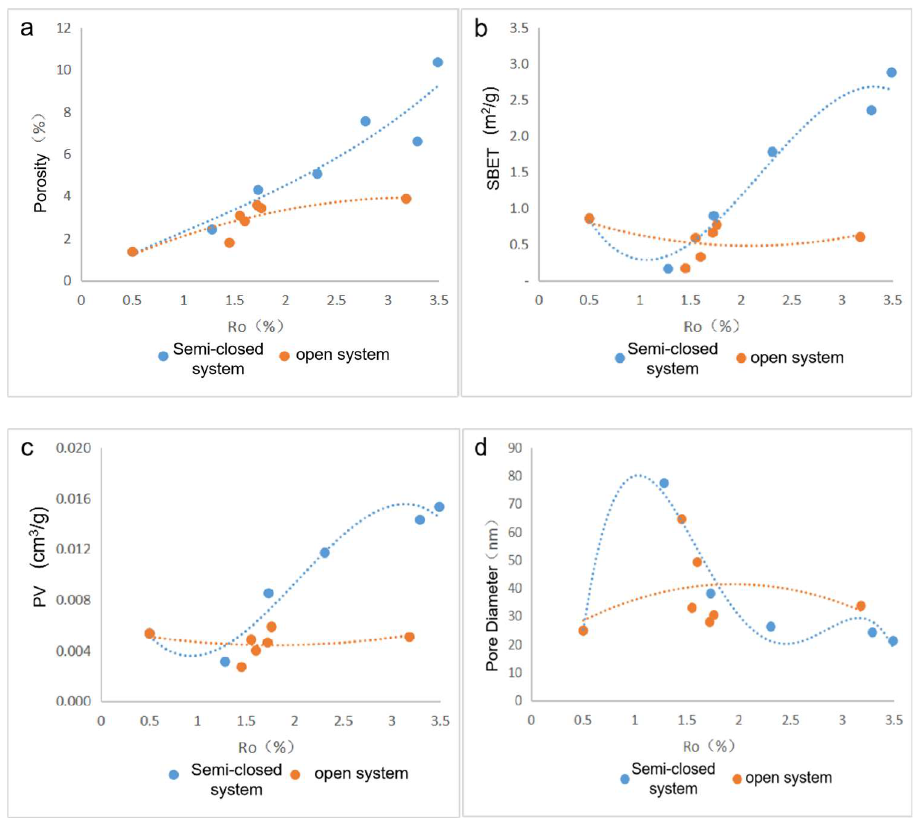
Figure 11. Variation trend of the pore structure parameters with maturity. ( a ) Ro-Porosity ( b ) Ro-SBET ( c ) Ro-PV and ( d ) Ro-Pore diameter.